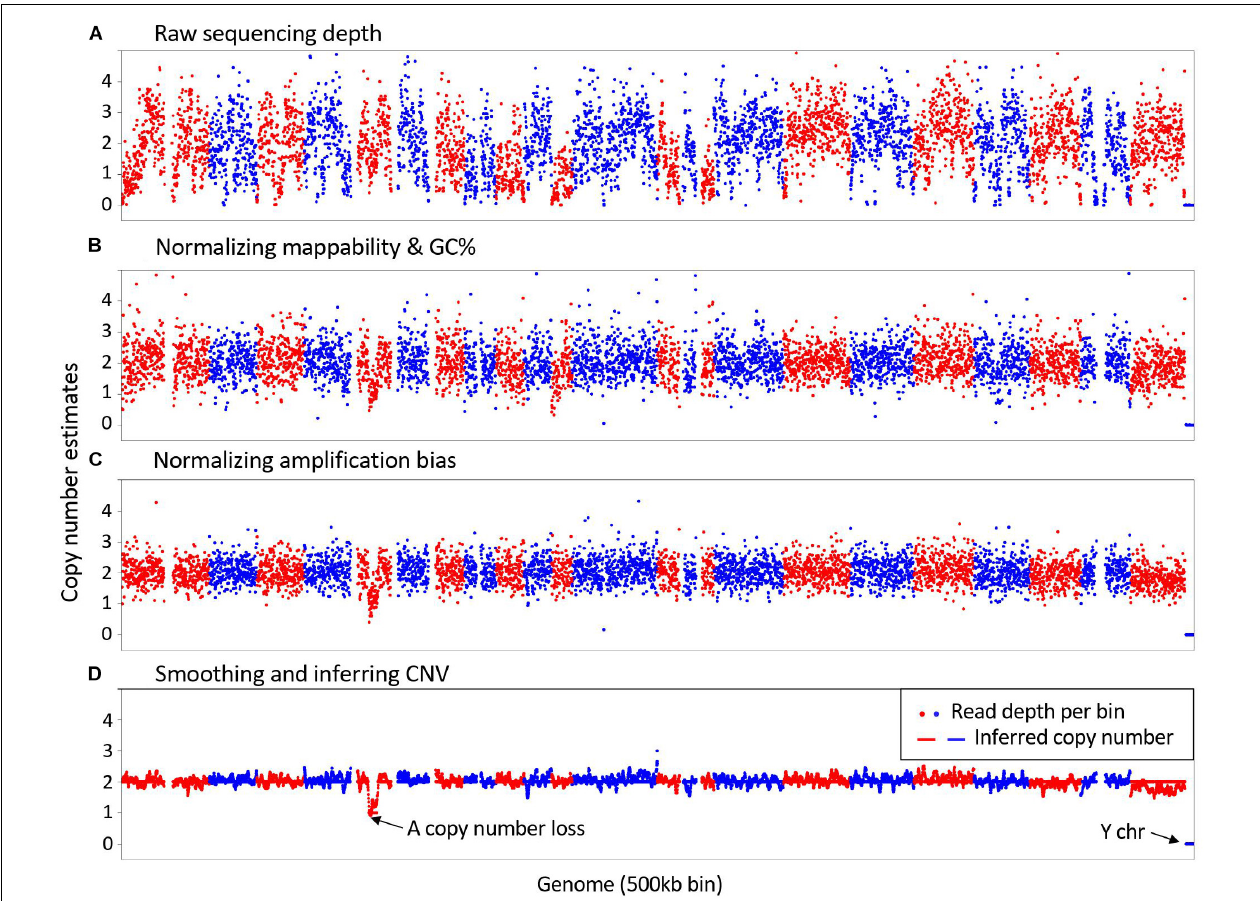
FIGURE 1 | Major steps in SCCNV. A example of copy number estimates of (A) Raw sequencing depth; (B) after normalizing mappability and GC content; (C) after normalizing amplification bias; and (D) final results is presented. The example is a normal neuronal nucleus amplified with MDA (SRA id: SRR2141574). Each dot presents a 500 kb bin in the genome. Red and blue colors indicate bins of different chromosomes in Red and blue colors present bins of different chromosomes in their lexicographic